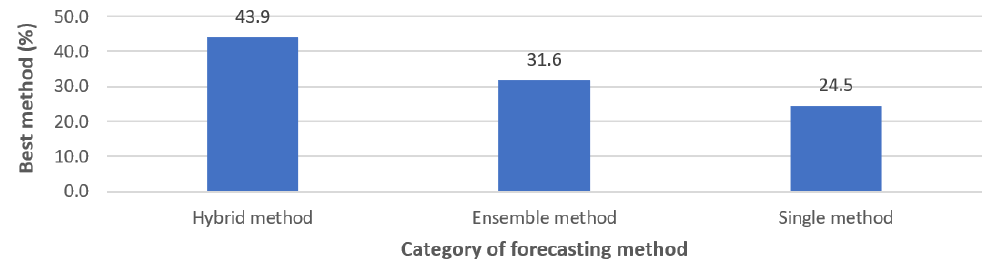
Figure 4. Frequency of using forecasting methods (quantity statistics).